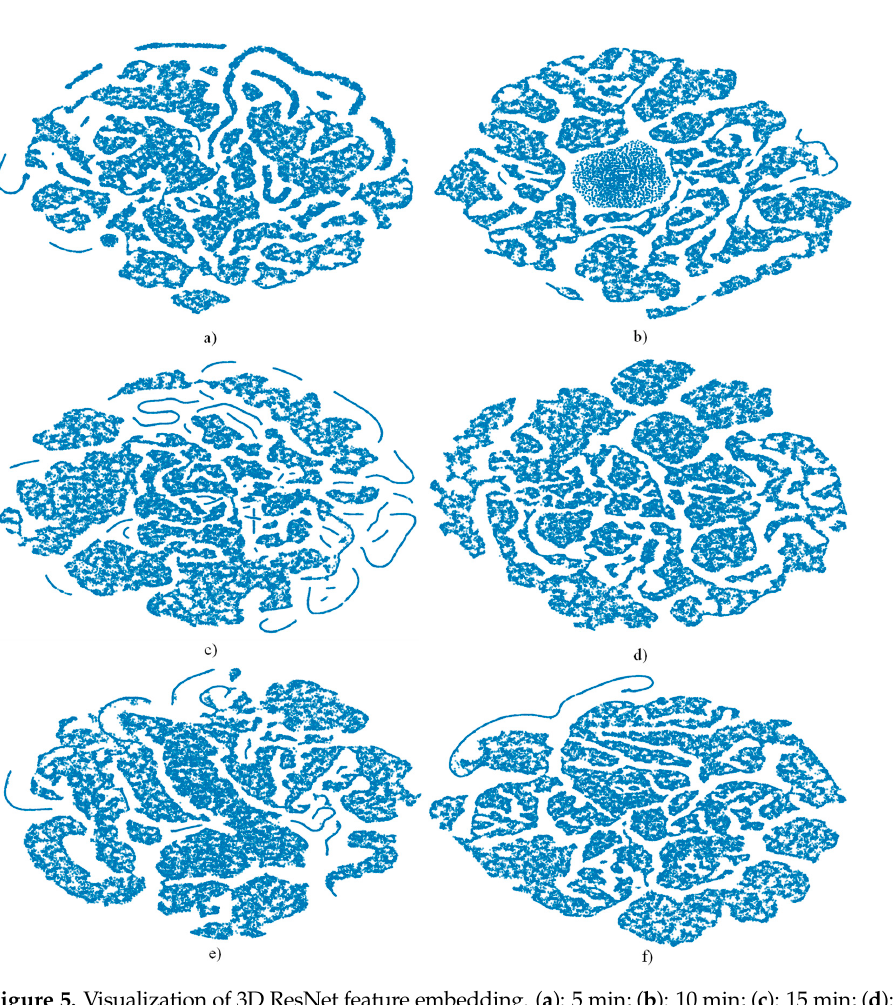
Figure 5. Visualization of 3D ResNet feature embedding. ( a ): 5 min; ( b ): 10 min; ( c ): 15 min; ( d ): 20 min; ( e ): 25 min; and ( f ): 30 min.